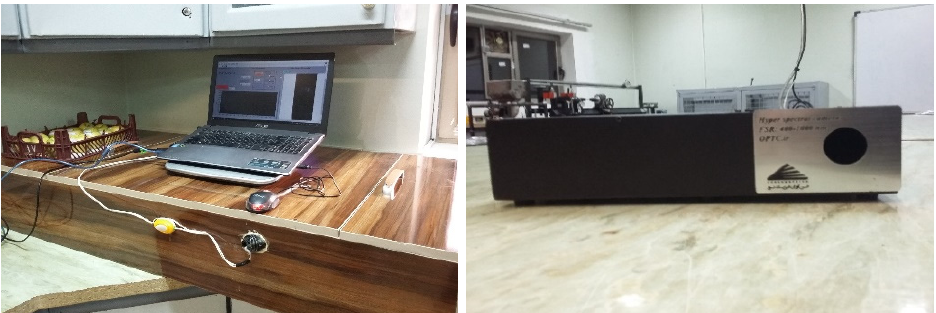
Figure 2. Hyperspectral imaging of samples.